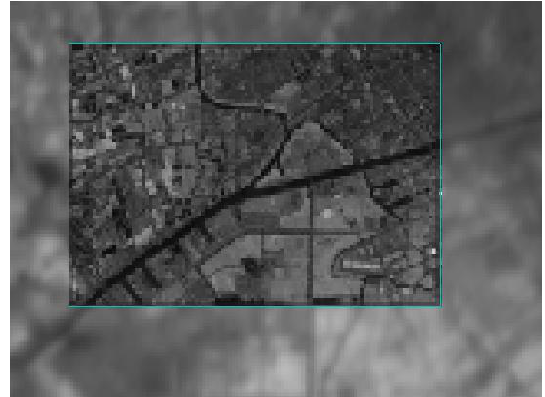
Figure 5. With RPC correction of August 14